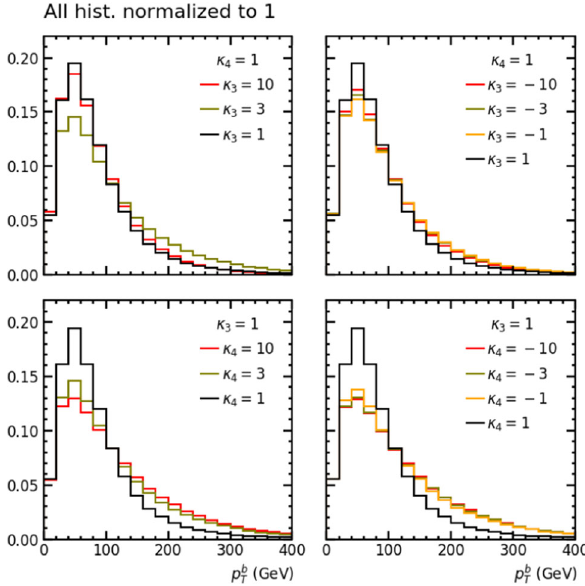
Fig. 34 Distribution of e + e − → b ¯ bb ¯ bb ¯ b ν ¯ ν events with respect to the transverse momentum of the b -jets, for several values of the parameters κ κ 3 and